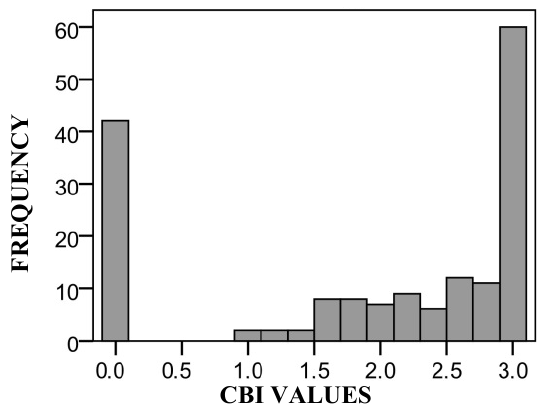
Figure 2. Frequency histogram of the CBI